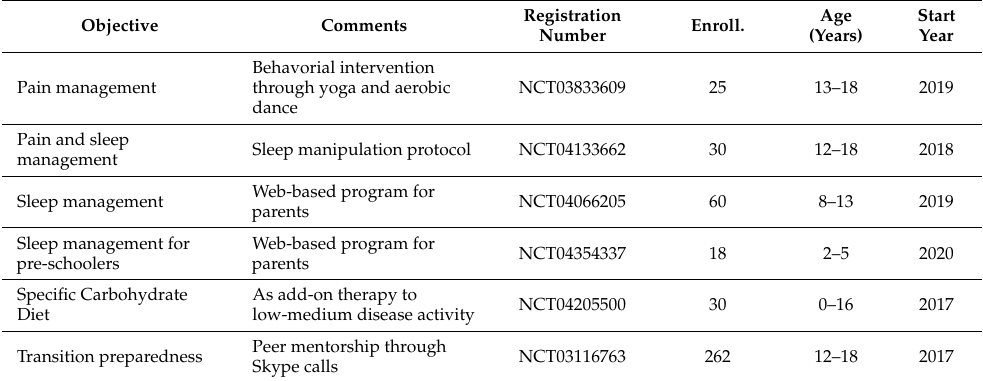
Table 5. Registered studies on non-medication